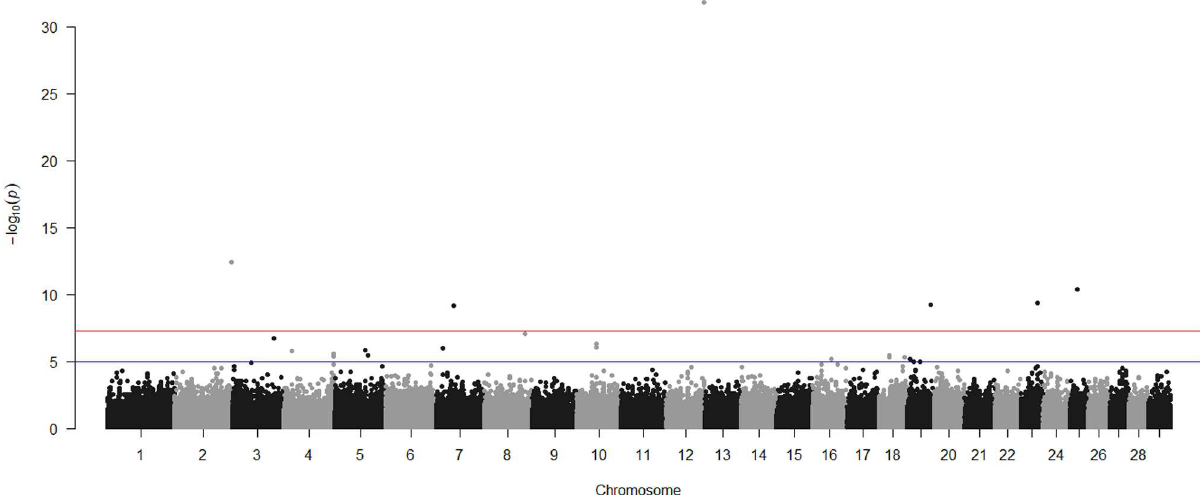
Fig 1. Manhattan plot of genome-wide single nucleotide polymorphisms (SNPs) associated with initial response to vaccination with E . coli O157: H7 Siderophore and Receptor Porin (SRP) proteins in calves ( n = 651). Red line = Genome-Wide Significance Level ( P < 5 x 10 − 8 ); Blue line = Suggestive Significance Level ( P < 1 x 10 −5 ). A genomic relationship matrix was used for this Manhattan Plot, but similar results were obtained using a pedigree relationship matrix (results not